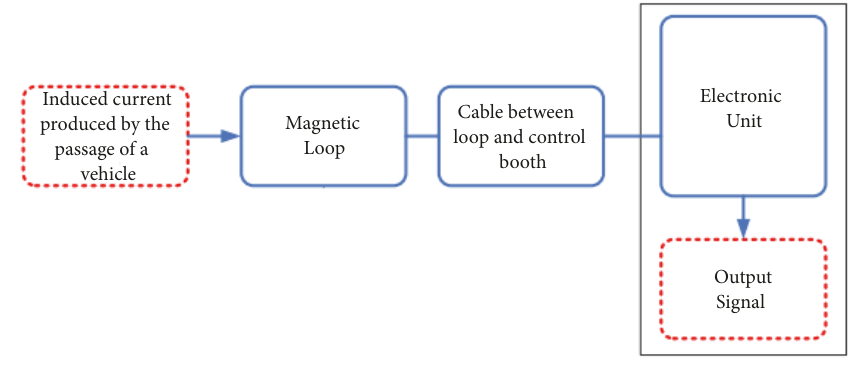
Figure 1: Magnetic loop system scheme.